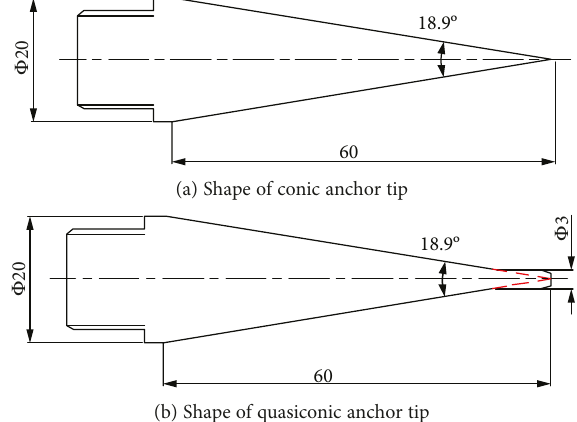
Figure 13: Schematic diagram of the conical anchor tip.